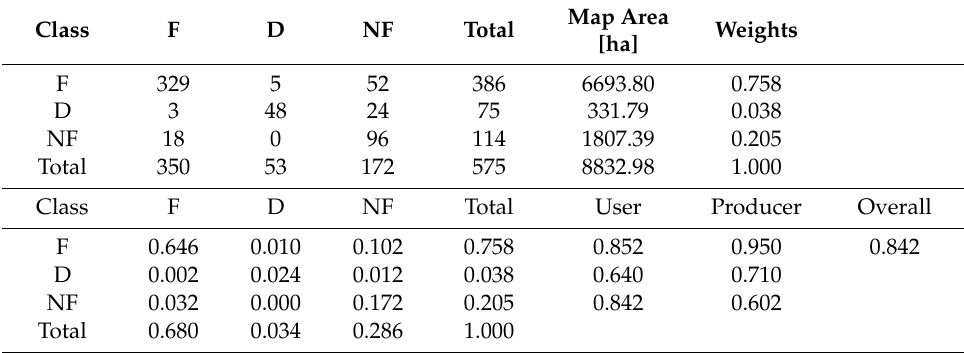
Table A5. “Union” Peru disturbance map validation.